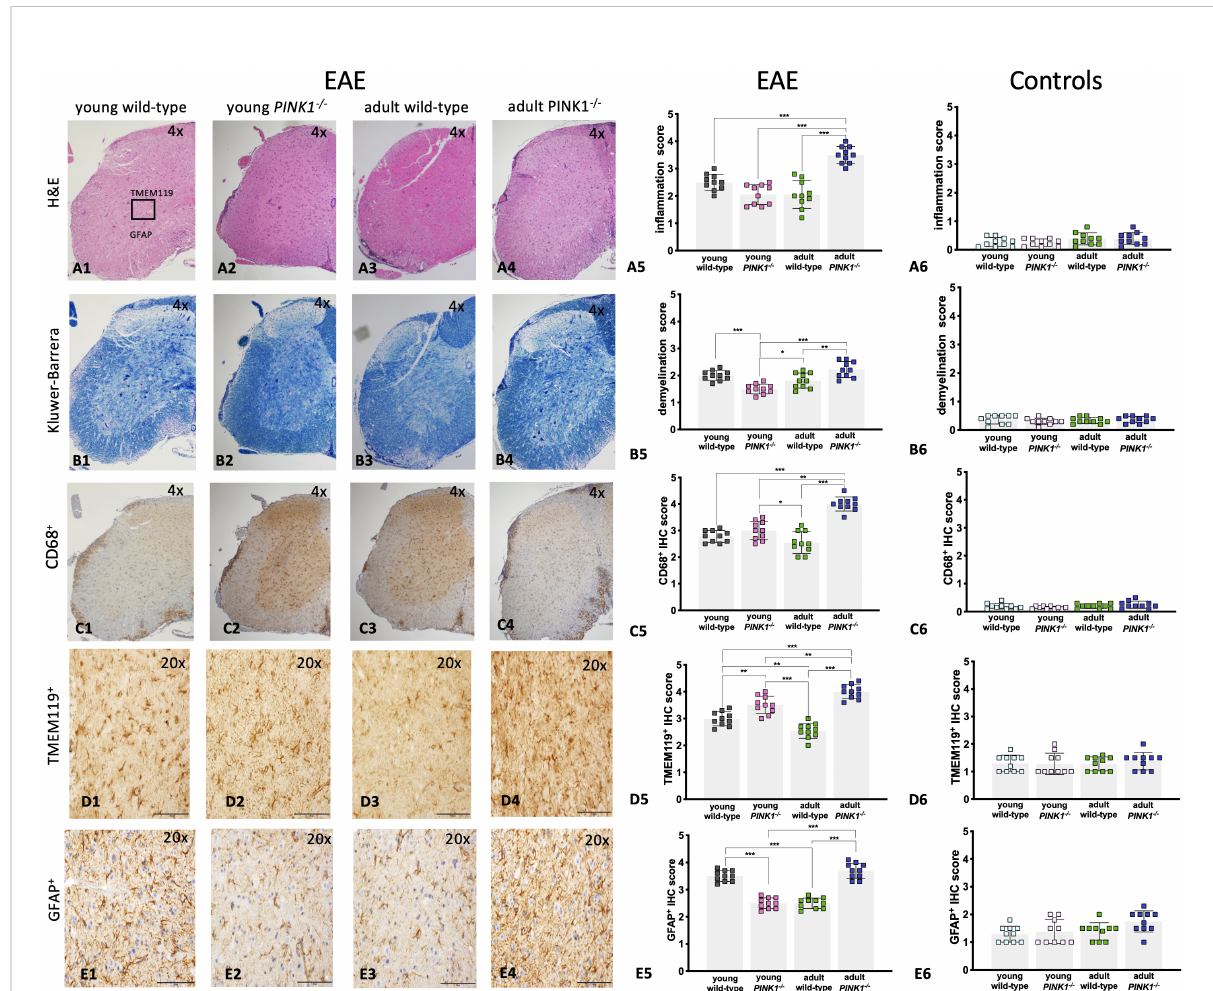
FIGURE 2 Histological and immunohistochemical analysis of the spinal cord tissue among groups during the EAE acute phase. (A1 – A4) histological images of in fl ammatory cell in fi ltration (scale bar = 200 um); (B1 – B4) extent of demyelination determined by Klüver-Barrera staining (scale bar = 200 um); C1 – C4 images of in fi ltrated CD68 + macrophages/monocytes in the white matter (scale bar = 200 um); (D1 – D4) images of TMEM119 + microglia expression in the gray matter (scale bar = 100 um); (E1 – E4) images of GFAP + astrocytes expression in the gray matter (scale bar = 100 um); for the semi quantitative analysis of EAE mice (A5 – E5) and no immunized controls (A6-E6), stain-positive cells in the lumbar spinal cord were counted in two randomly chosen sections for fi ve mice of each group. Data were analyzed using one-way ANOVA followed by post-hoc Dunnett ’ s multiple comparison test. Each symbol represents an individual mice/* p < 0.0, ** p < 0.01, *** p < 0.001.